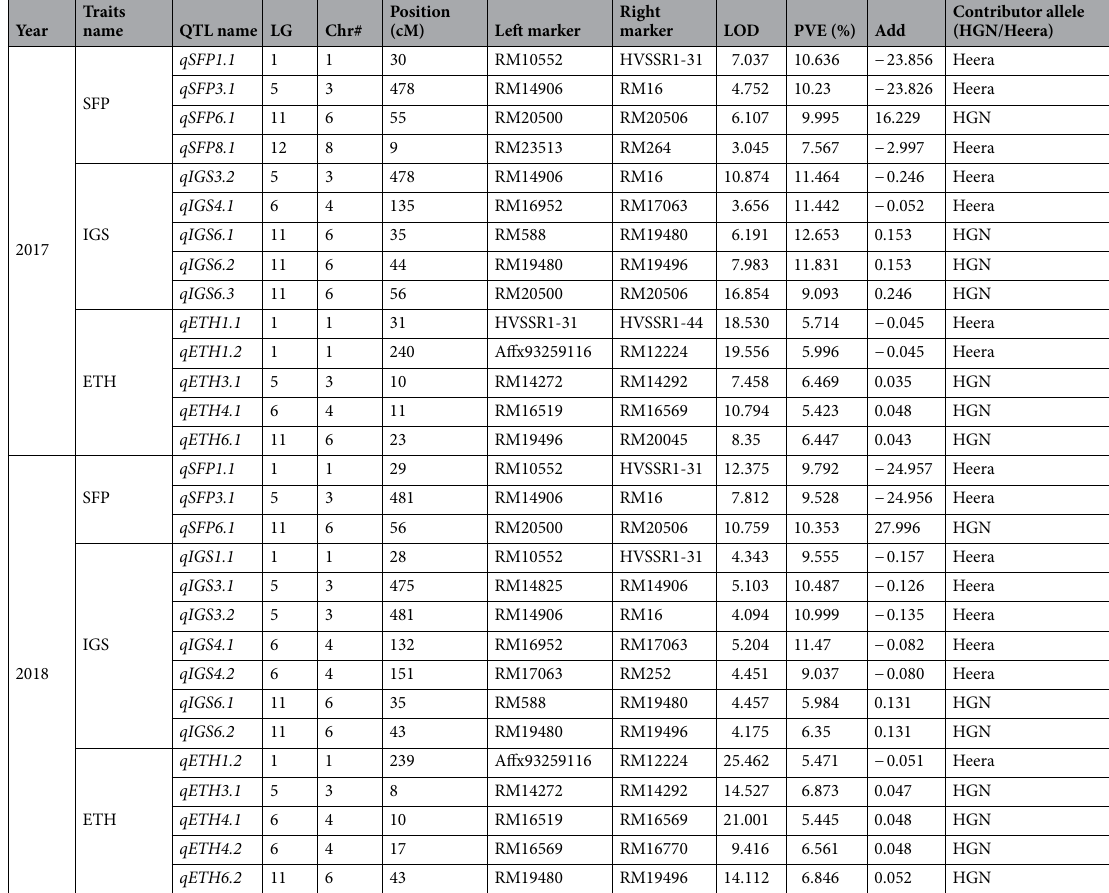
Table 3. QTLs identified for spikelet fertility percentage (SFP), inter-grain space (IGS) and ethylene production (ETH) using RILs derived from PDK Shriram (HGN) and Heera in kharif seasons of 2017 and 2018. LG-Linkage group; Chr#—Chromosome number, PVE-phenotypic